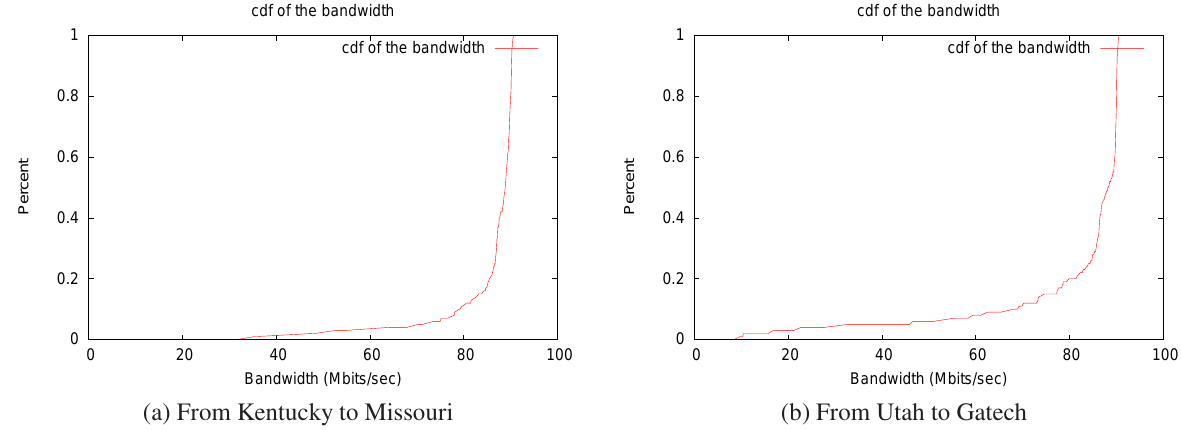
Figure 10. cdf of bandwidth of links cross